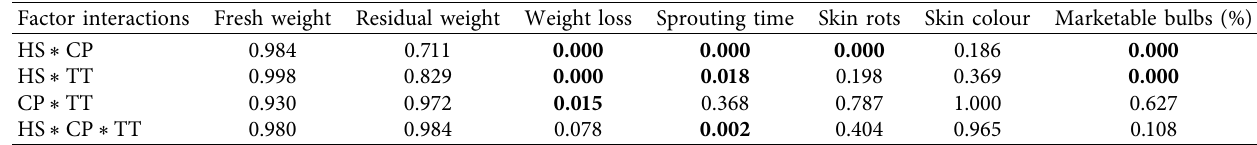
Table 6: p values of interactions between different treatment factors.